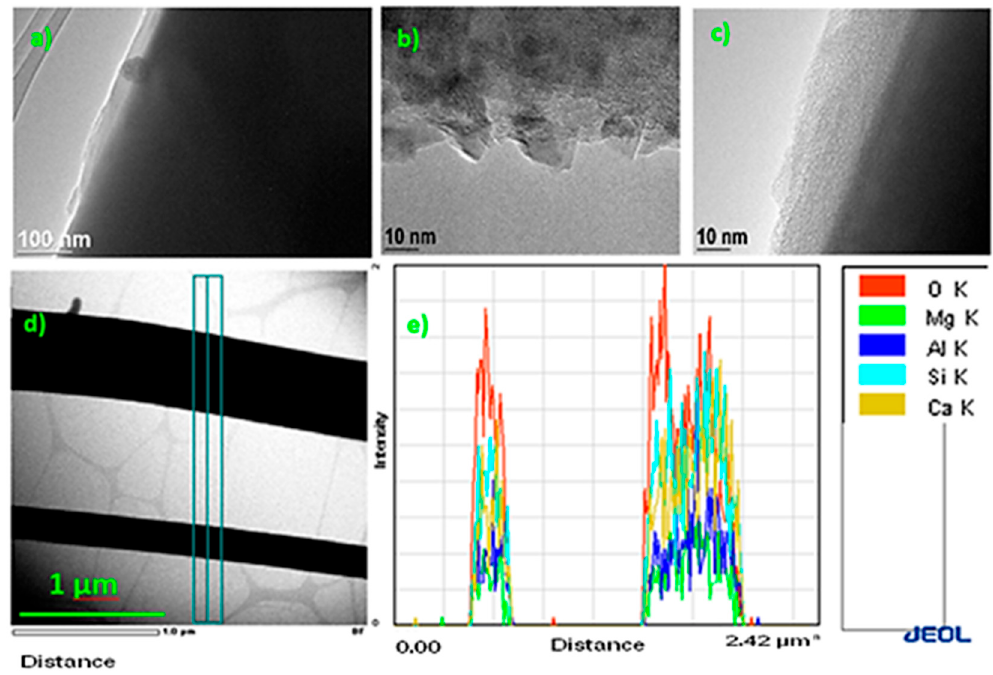
Figure 9. Scanning transmission electron microscope analysis of fiber surface in nano-scale. Visible formation of a thin ribbed layer on the aged basalt surface ( a – c ), the parallel cross section of basalt fiber ( d ), and presence of elements on the surface and in the interior ( e ).